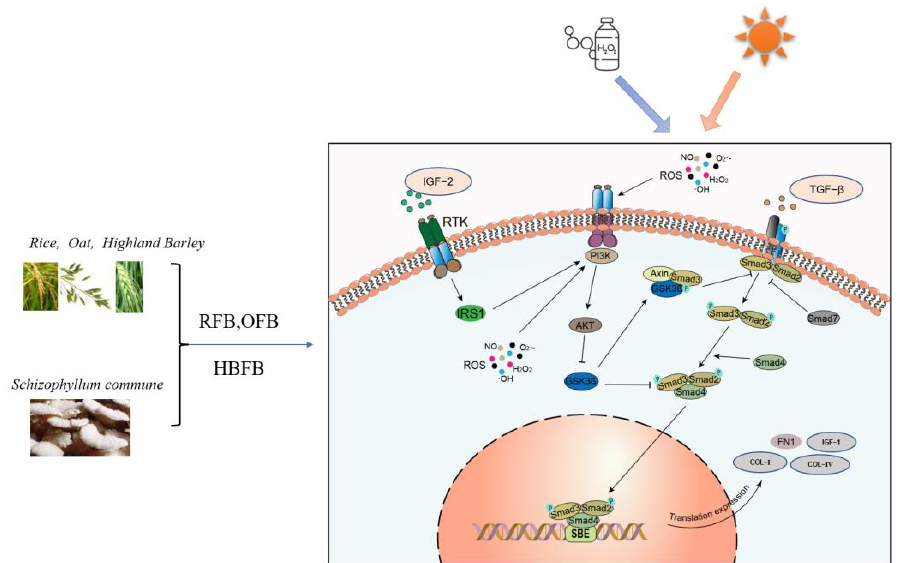
Figure 6. RFB, HBFB and OFB influence the signaling pathways of UVA / H 2 O 2 -induced skin oxida- tive damage. RFB, HBFB, and OFB are three kinds of S. commune fermentation broths. RFB, rice fermentation broth; HBFB, highland barley fermentation broth; OFB, oats fermented broth.